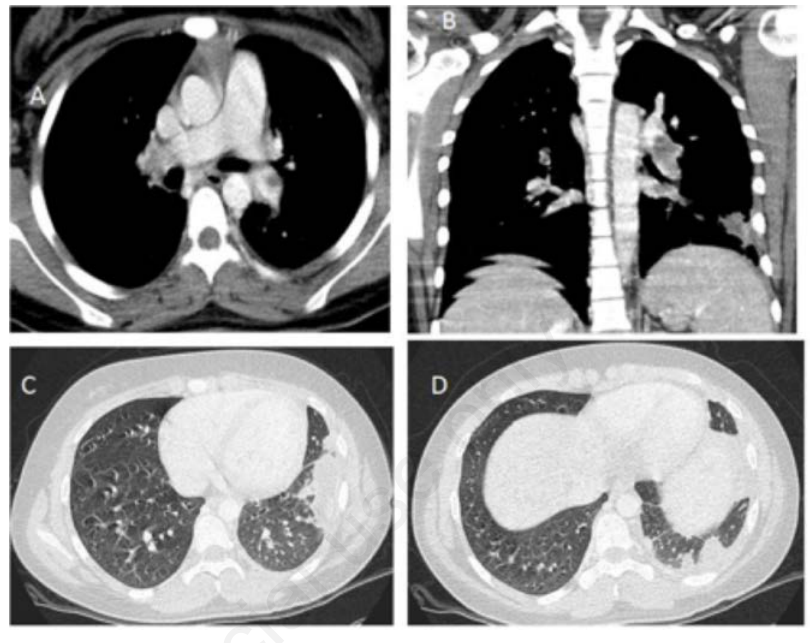
Figure 2. Contrast enhanced CT scan obtained on presentation shows multiple bilateral filling defects in distal pulmonary arteries and segmental branches more on the left con- sistent with pulmonary embolism A) axial, B), coronal. C, D) Axial lung windows show multiple peripheral wedge shaped left lower lobe opacities suggestive of pulmonary infarctions. Table 1. Laboratory findings on admission.